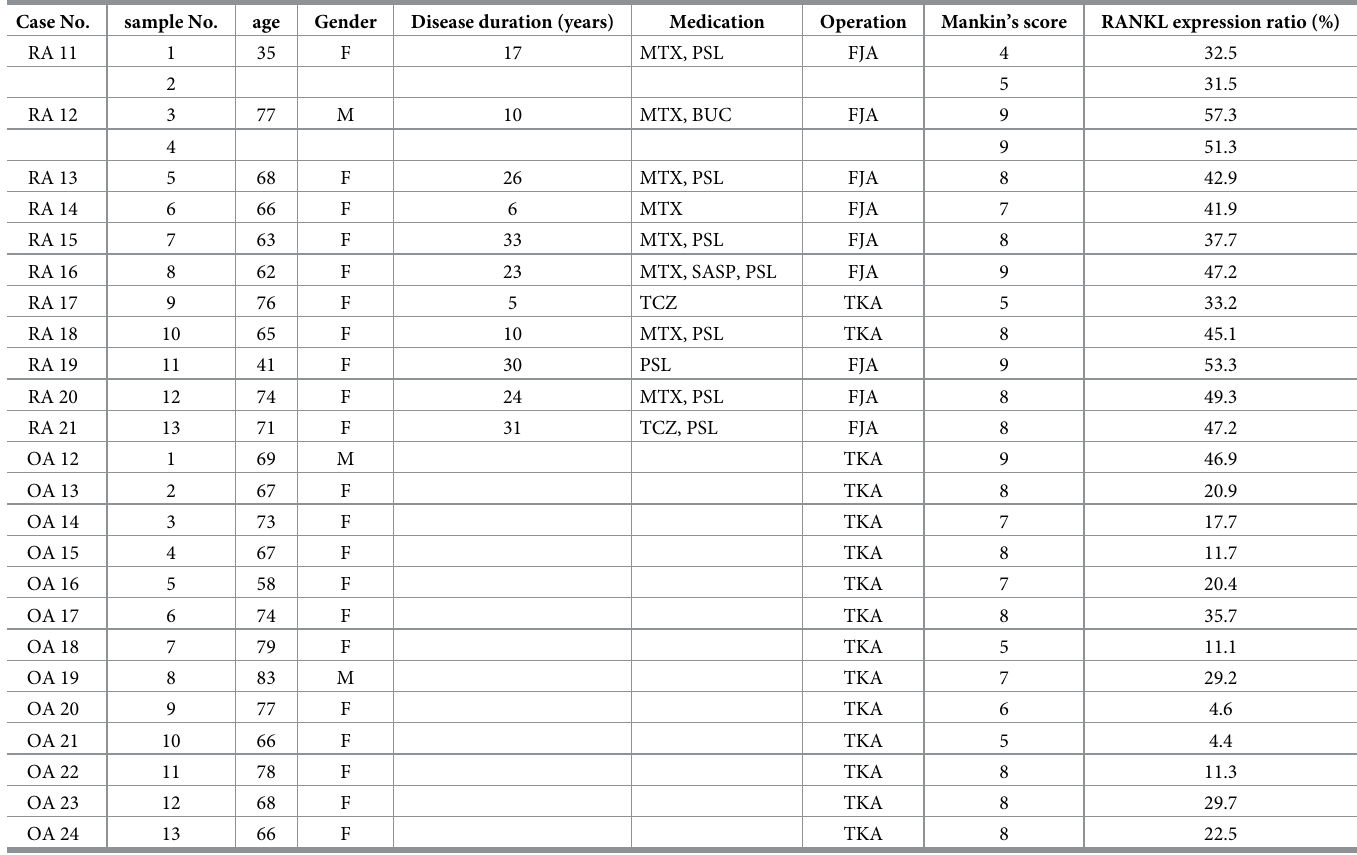
Table 2. Individual patient data and Mankin’s score and RANKL expression ratio in articular cartilage samples. Case No. sample